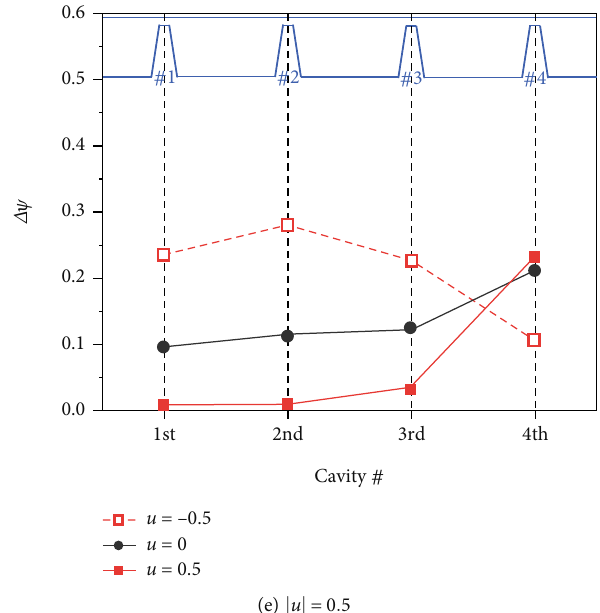
= 0 : 23 , and C = 0 : 067 ). U